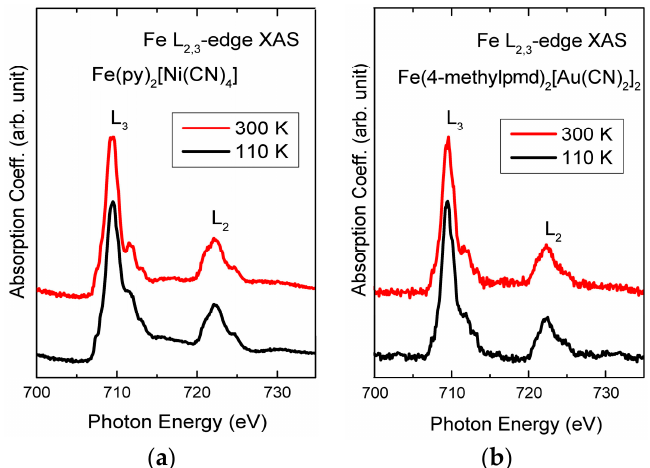
Figure 5. Fe L 2,3 -edge XAS spectra of ( a ) Fe(4-methylpmd) 2 [Au(CN) 2 ] 2 and ( b ) Fe(py) 2 [Ni(CN) 4 ] polymers. HS configuration was dominant even at 110 K (below T C ), suggesting SOXIESST effects for the loosely coordinated polymers.